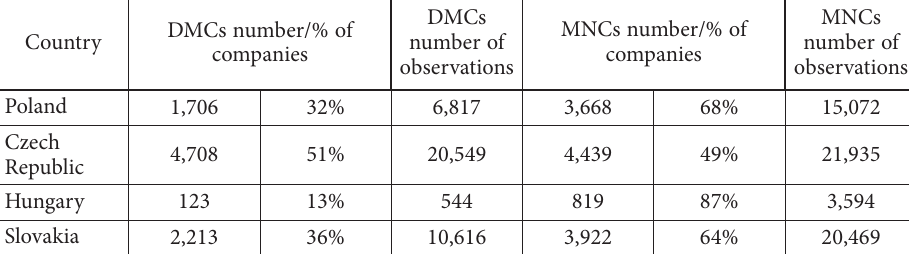
Table 2. The research